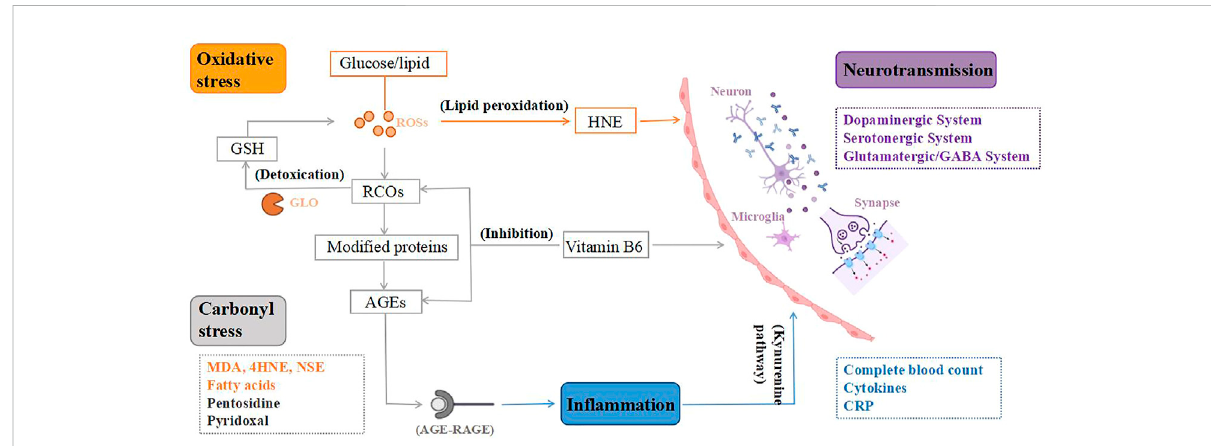
FIGURE 2 From peripheral biomarkers to neurobiology of treatment-resistant schizophrenia (TRS). To begin with, the lipid peroxidation product 4- hydroxynonenal (HNE) created by oxidative stress can alter the blood-brain barrier, and peroxidation also causes aberrant fatty acid levels in the synaptic membrane, leading to an altered neuronal microenvironment. Second, oxidative stress is a key mediator of carbonyl stress, as glucose and lipids are transformed to reactive carbonyl compounds (RCOs), and excess RCOs are converted to advanced glycation end products (AGEs). Glyoxalase converts RCOs to glutathione (GSH), which is an antioxidant. Vitamin B6 detoxi fi es RCOs and AGEs, and its de fi ciency can impact the metabolism of many neurotransmitters, resulting in various neurotransmission de fi cits in brain function. Third, AGEs interact with the AGE receptor (RAGE), causing in fl ammation to rise. Increased neurotoxic metabolites as a result of in fl ammatory damage mediated by the Kynurenine pathway. Microgliaarealsoactivated,releasingin fl ammatorycytokinesthatcausedysregulationofneuronalcircuitsandneurodegeneration.Therefore,TRS,a neurological disorder, is caused by the combination of mentioned mechanisms. ROSs, reactive oxygen species; GLO,